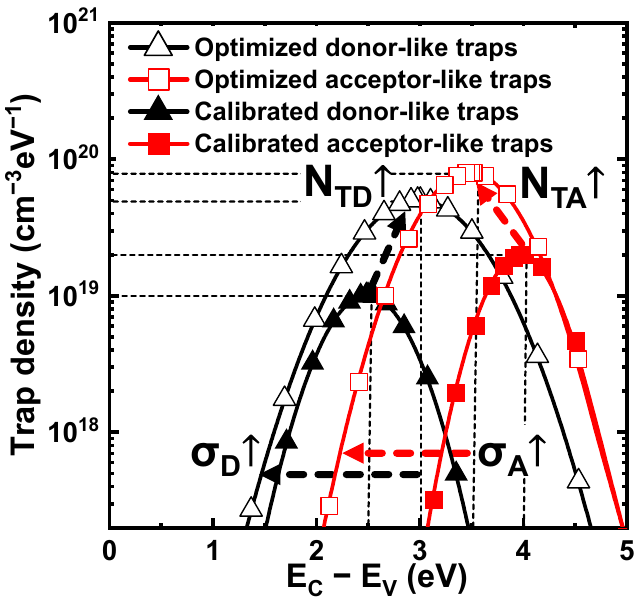
Figure 8. Comparison of profiles between optimized (open) and calibrated (closed) energetic-trap distributions. N TD , N TA , σ D , and σ A strongly influence the V th window.